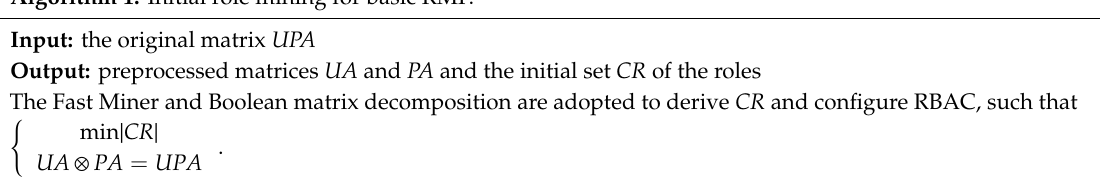
Algorithm 1. Initial role mining for basic